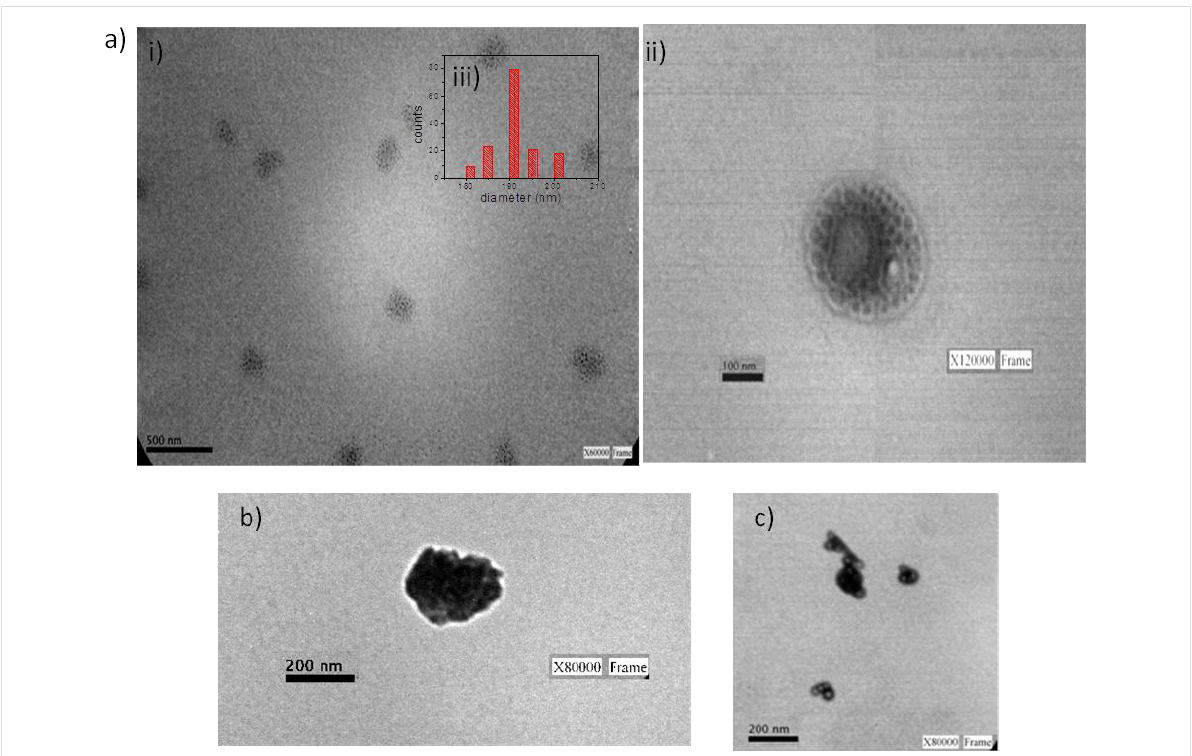
Figure 7: TEM images of AuNPs–SH–DOPC LUVs. a) i) and ii) TEM images of AuNPs–SH–DOPC LUVs using AuNPs synthesized in glycerol with 8 min of irradiation time and LUVs prepared with a SH/DOPC molar ratio of 0.33:1. iii) Diameter histograms of the AuNPs–SH–DOPC LUVs based on the inspection of 150 LUVs. b) AuNPs–SH–DOPC LUVs using AuNPs synthesized in glycerol with 8 min of irradiation time and LUVs prepared with a SH/DOPC molar ratio of 0.66:1. c) AuNPs–SH–DOPC LUVs by using AuNPs synthesized in glycerol with 13 min of irradiation time and LUVs pre- pared with a SH/DOPC molar ratio of